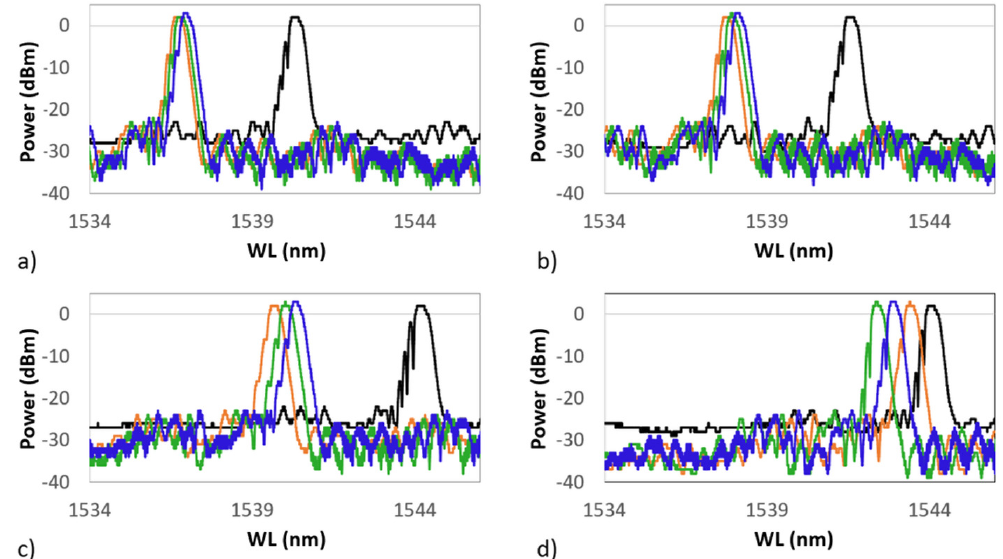
Figure 13. Grating spectra grouped by temperature value. ( a ) The grating spectrum at 100 ◦ C; ( b ) at 300 ◦ C; ( c ) at 500 ◦ C; and ( d ) at 700 ◦ C. After the first cycle, all following cycles begin around the new wavelength value at RT. In black is shown the first cycle, in red the second, in green the third, and in blue the